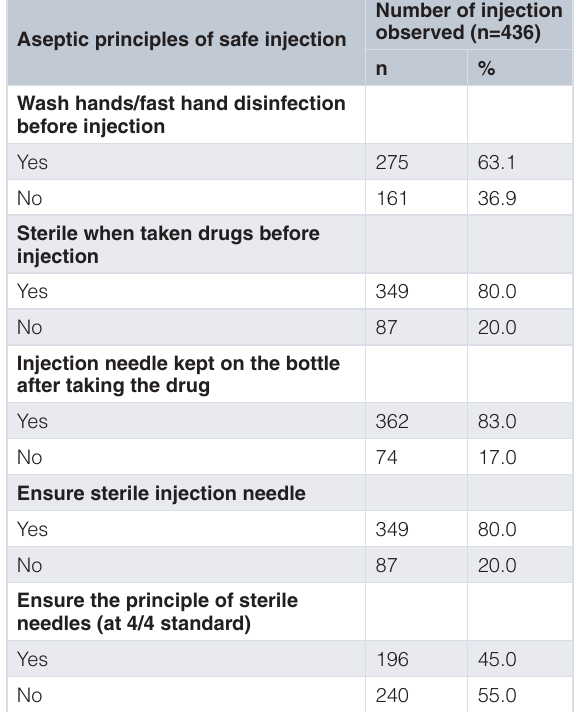
Table 3. Percentage of compliance with aseptic principles of injection safety, as collected via